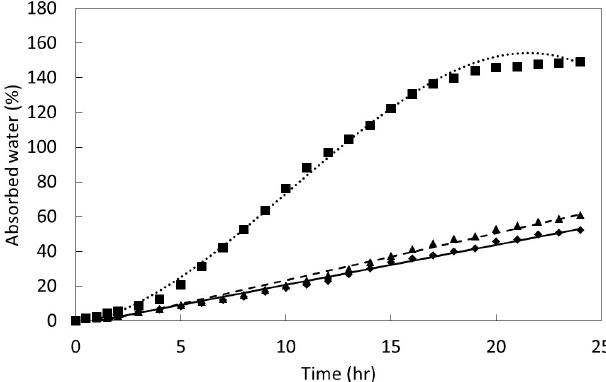
Figure 2. The influence of time in aerated water on water absorption of scarified seeds of three Serianthes species, n = 6. Serianthes grandiflora (squares, dotted line), y = −1.57 + 1.93 x + 0.83 x 2 − 0.03 x 3 , r 2 = 0.98; Serianthes kanehirae (triangles, dashed line), y = −3.39 + 2.71 x , r 2 = 0.98; Serianthes nelsonii (diamonds, solid line), y = −2.27 + 2.31 x , r 2 = 0.98.